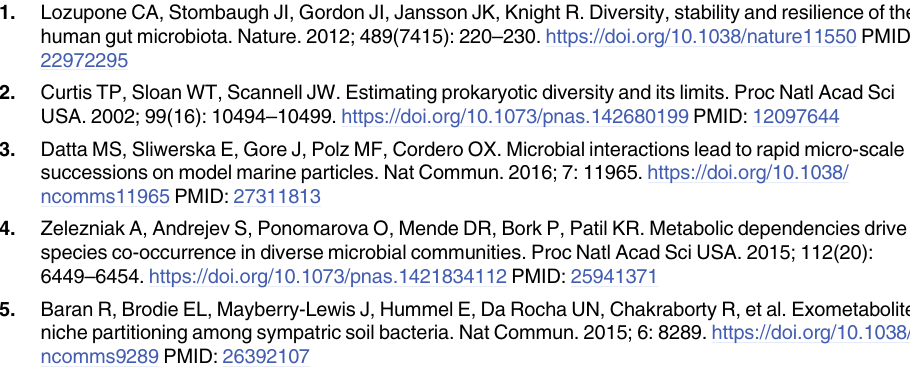
S8 Fig. Examples of (A) resilient and (B) non-resilient coexistence. (A) The removal of any species does not cause the extinction of another species (average survival ratio is 1). (B) The removal of cell species B leads to the extinction of the other three cell species (C,D,E) leaving only cell species A in the community (average survival ratio is 0.8). Blue and red indicate the leakage and uptake of each chemical component, respectively. In both simulations, the parameters are